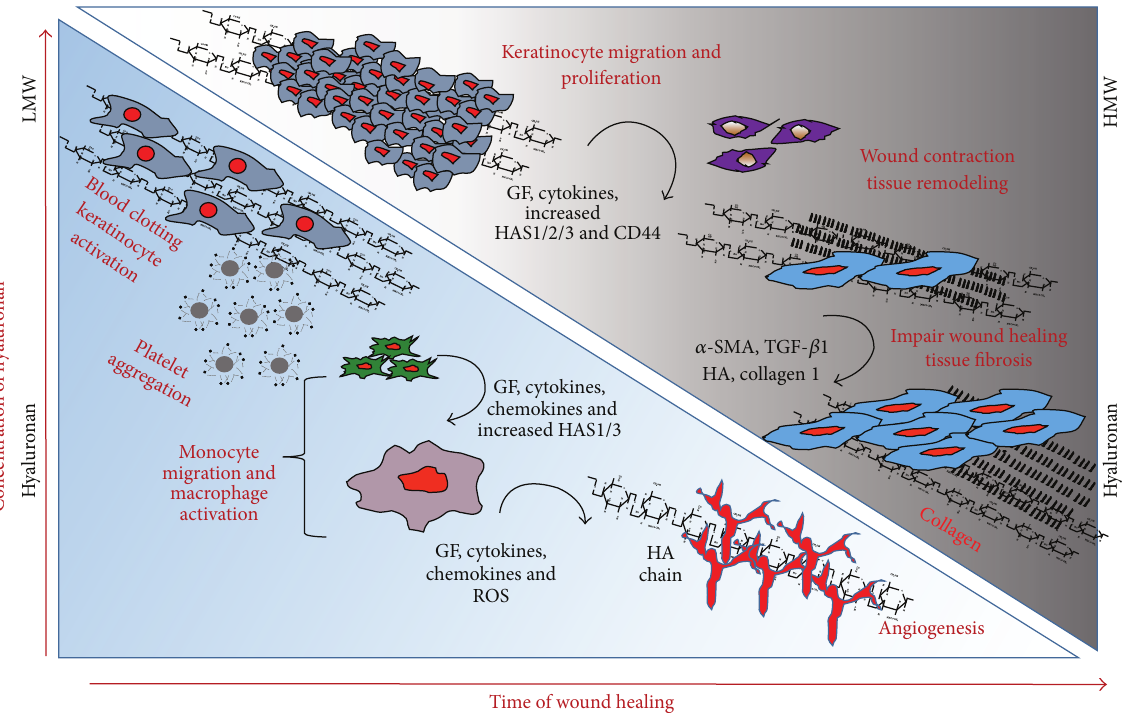
Figure 1: Schematic presentation of changes in hyaluronan synthesis/molecular size and cellular events and matrix events during the course of wound healing and fibrosis. Many of the biological processes mediated by HA are crucial for wound healing and fibrosis. After injury, wound healing follows a tightly regulated sequence of events. These phases are inflammation, granulation tissue formation, proliferation, reepithelization, and remodelling. In the early phases, high molecular HA is degraded by reactive oxygen species from activated granulocytes and by hyaluronidases secreted from platelets. Then monocytes secrete inflammatory mediators, which attract additional inflammatory cells. Keratinocytes become activated to migrate, proliferate, and to synthesize HA. As a result the LMW degradation products are active inducers of angiogenesis and inflammation. At later stages the interim matrix becomes supplemented with newly synthesized HMW HA, which contributes to tissue remodelling. During repetitive injury, the repairing processes are hindered, and the keratinocytes , the endothelial cells, and smooth muscle cells of the blood vessel, neutrophils , and macrophages together orchestrate the increased cytokine-mediated signaling and augment HA-CD44 signaling and excess collagen production that results in